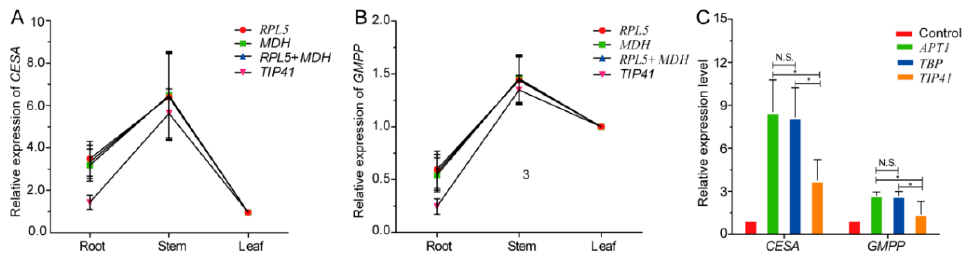
Figure 6. Relative expression levels of CESA and GMPP normalized by the selected reference genes in different tissues (root, stem, and leaf) and methyl jasmonate (MeJA) treatment. ( A ) The CESA expression level on different tissues; ( B ) The GMPP expression level in different tissues; ( C ) The CESA and GMPP expression level in the stem under MeJA treatment (* p < 0.05; Here, N.S. indicates no significant difference). The error bars represent the mean ± SD of three biological